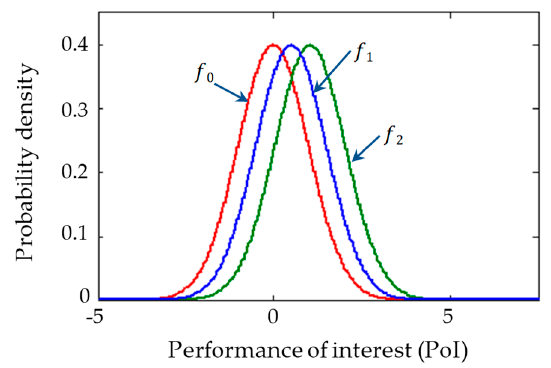
Figure 5. PDFs of the experimental and predicted results.